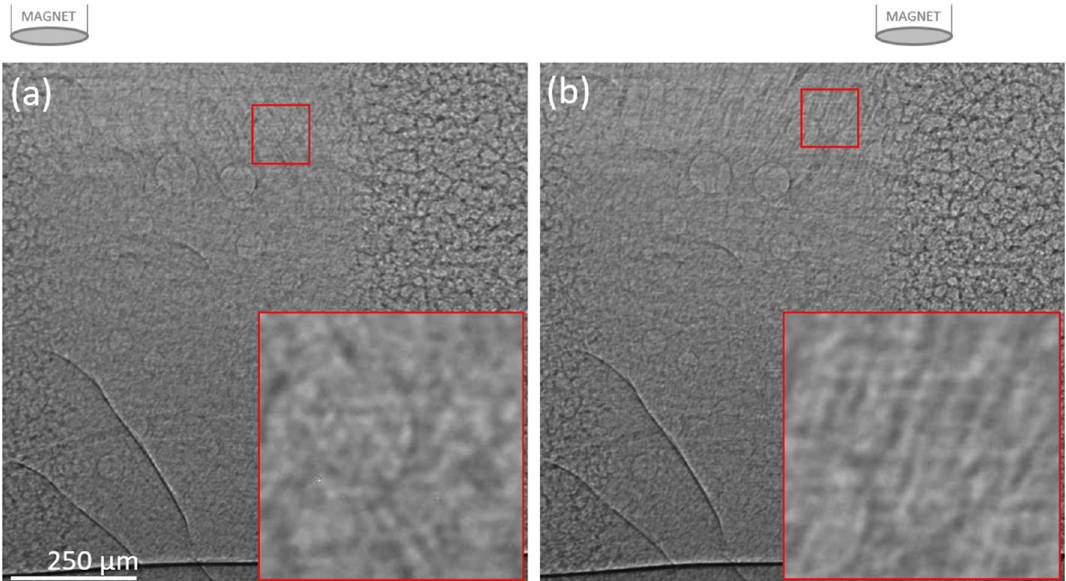
Figure 8. Example images showing MP5 within the trachea of a live anaesthetised rat. Images were acquired ( a ) with the magnet above and to the left of the trachea, and then ( b ) after the magnet was moved to the right. The red boxes contain contrast-enhanced enlargements. These images are from the video shown in Supplementary Video S7: